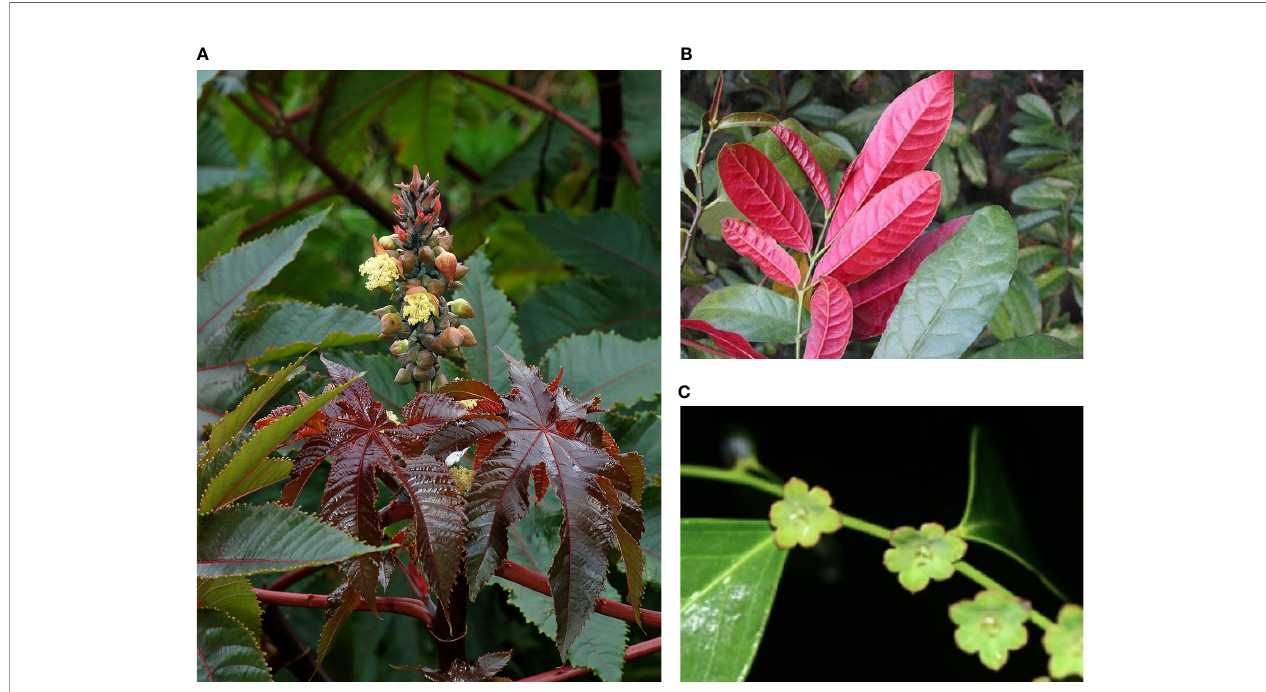
FIGURE 3 | Plant morphology of the three TCM. (A) Ricinus communis L (Source: Wikipedia), (B) Excoecaria cochinchinensis Lour, and (C) Breynia fruticosa (Source: